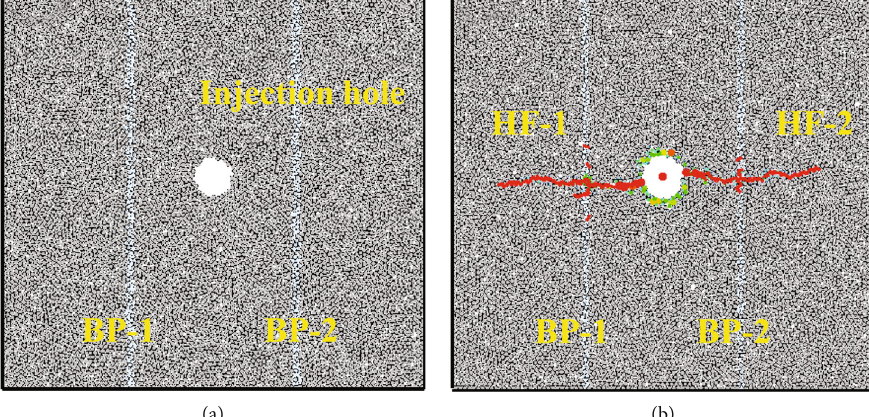
Figure 6: Group 1-1 hydraulic fracture test: (a) test block before hydraulic fracturing; (b) test block after hydraulic fracturing.